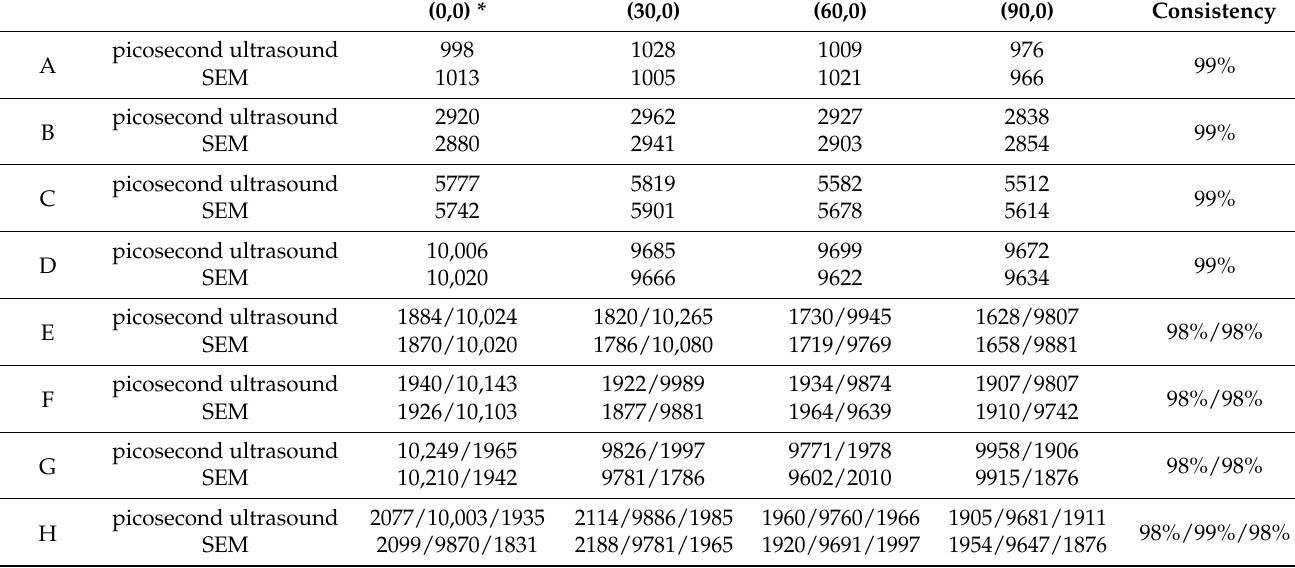
Table 2. Overview of picosecond ultrasound data and SEM data.